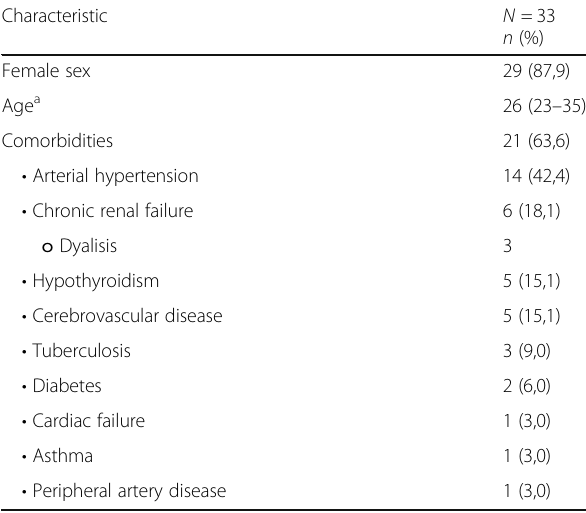
Table 1 Demographic characteristics of SLE patients